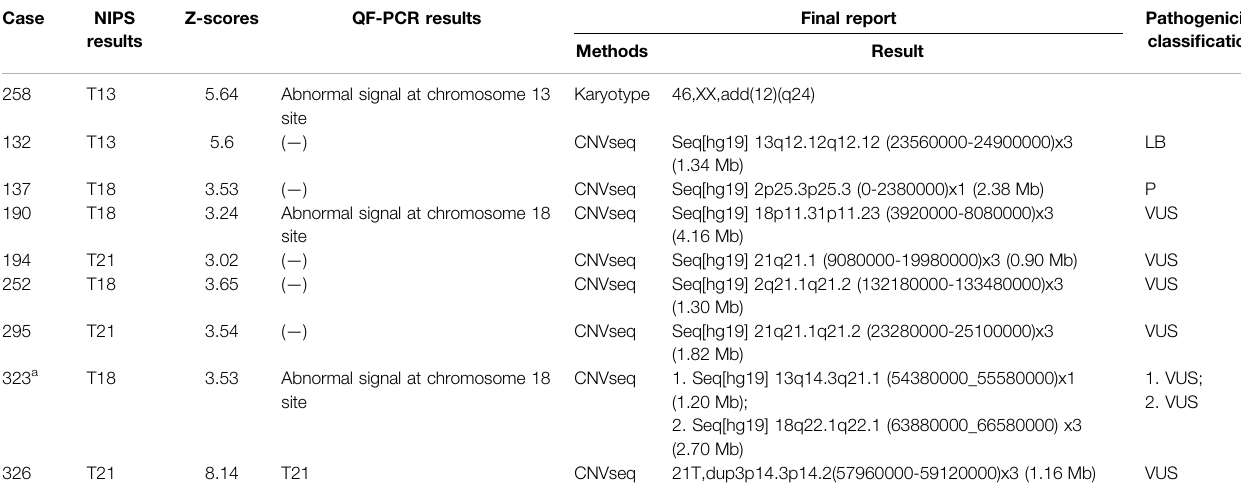
TABLE 3 | Additional fi ndings by amniocentesis in 9 cases with positive NIPS for main target diseases.